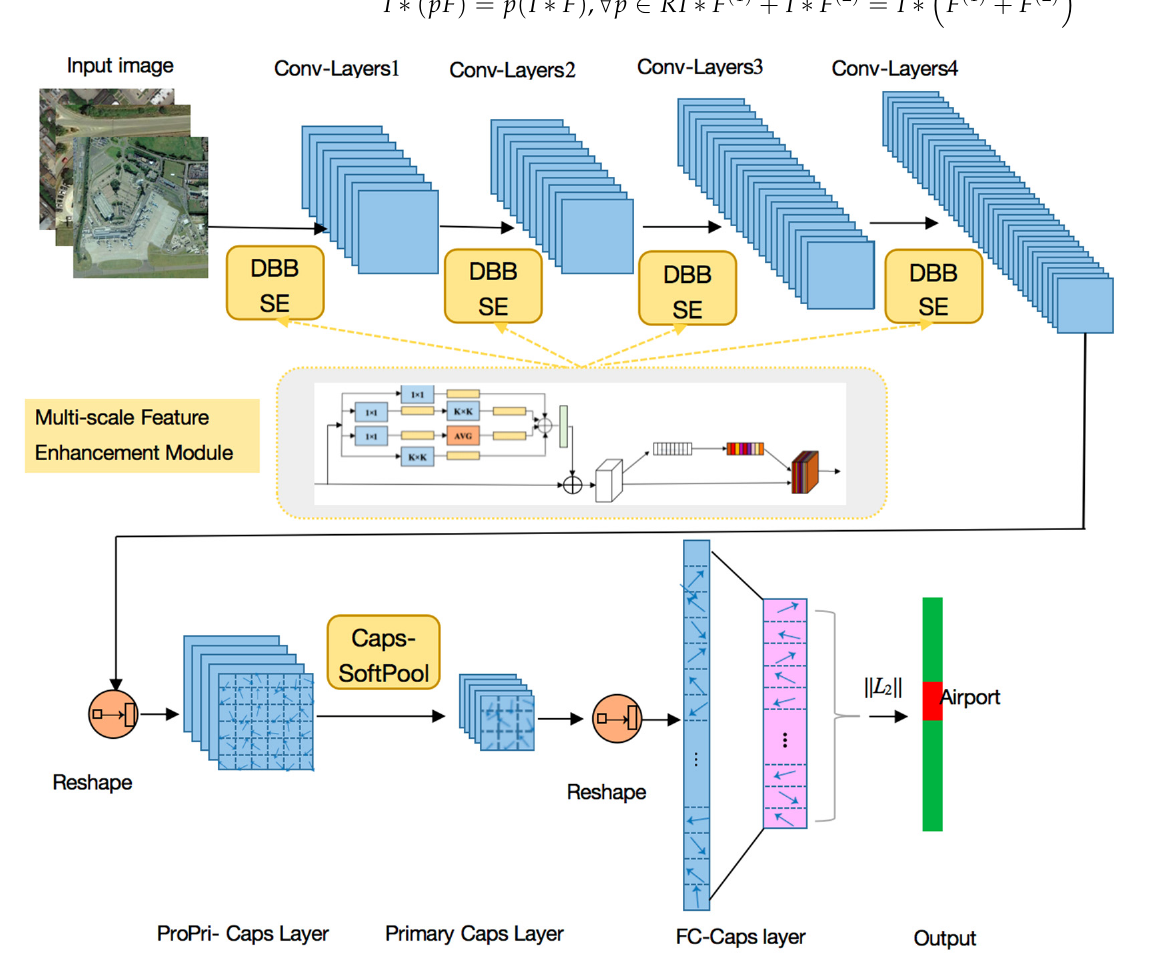
Figure 4. The main architecture of the DS-CapsNet.